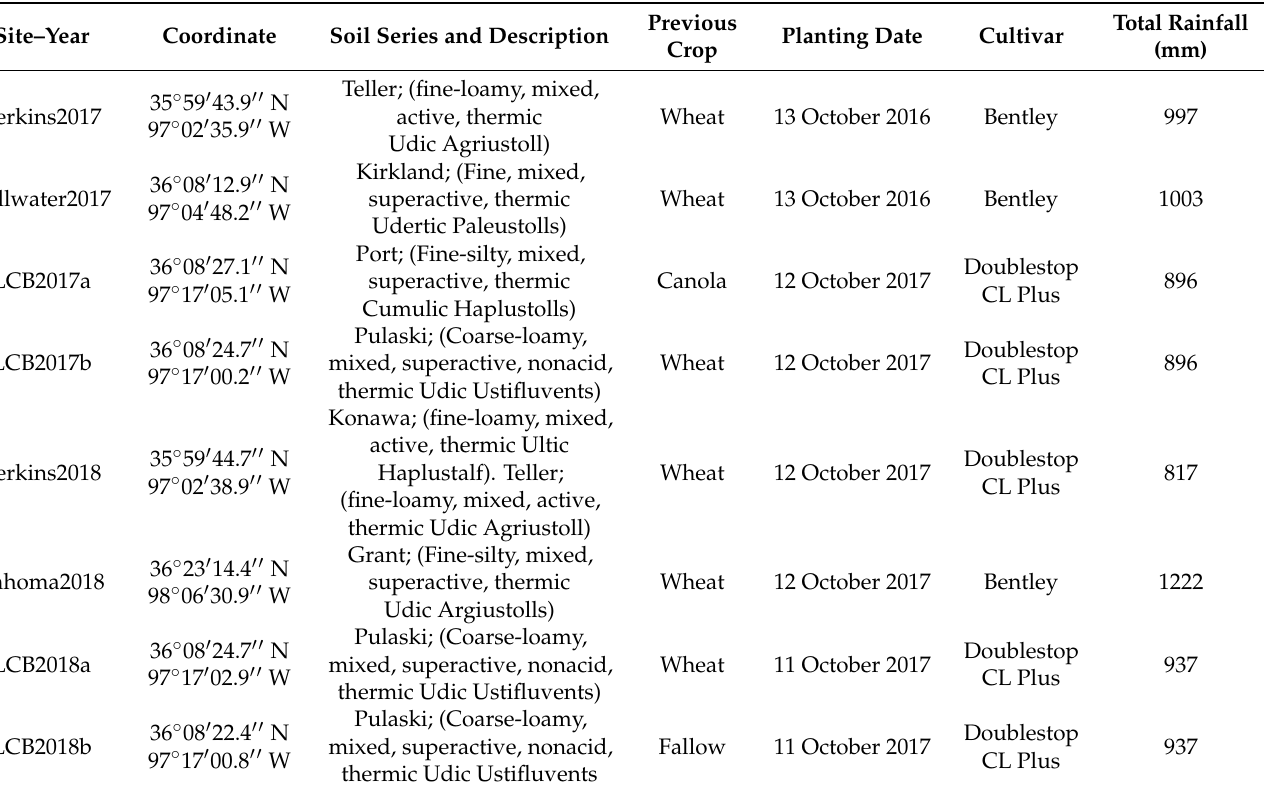
Table 1. Soil series classification and description, location, previous crop and planting date, and total rainfall (September to August) for all experimental sites utilized in the study. Previous Total Soil Series and Description Planting Date Cultivar Crop